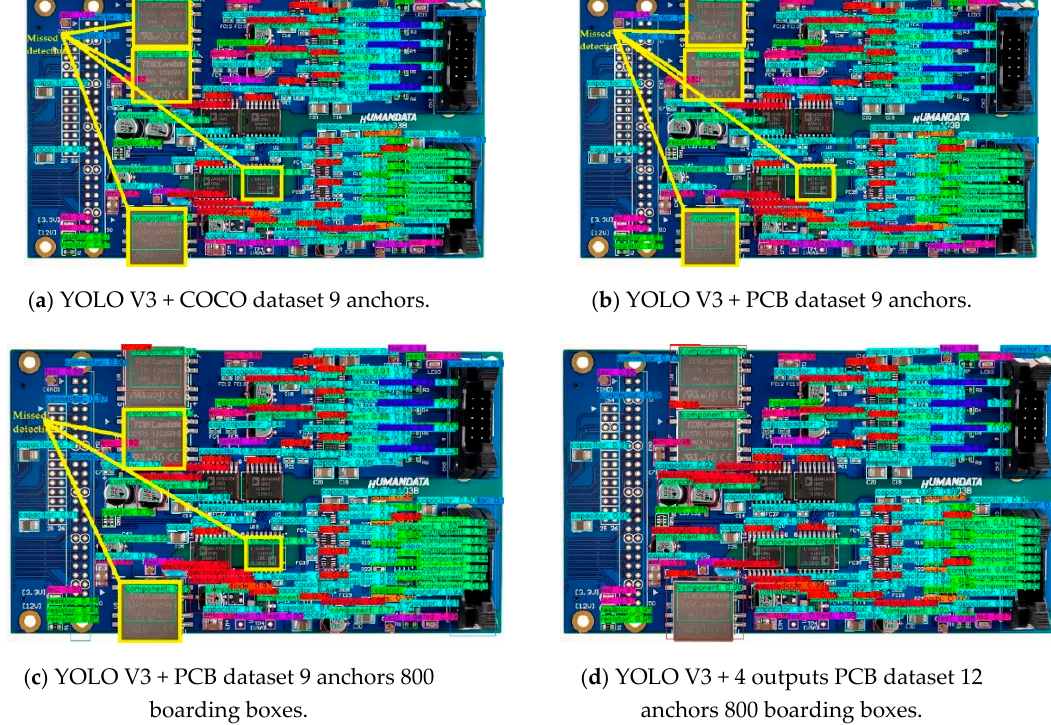
Figure 12. Comparisons of large object detection results between the four algorithms.